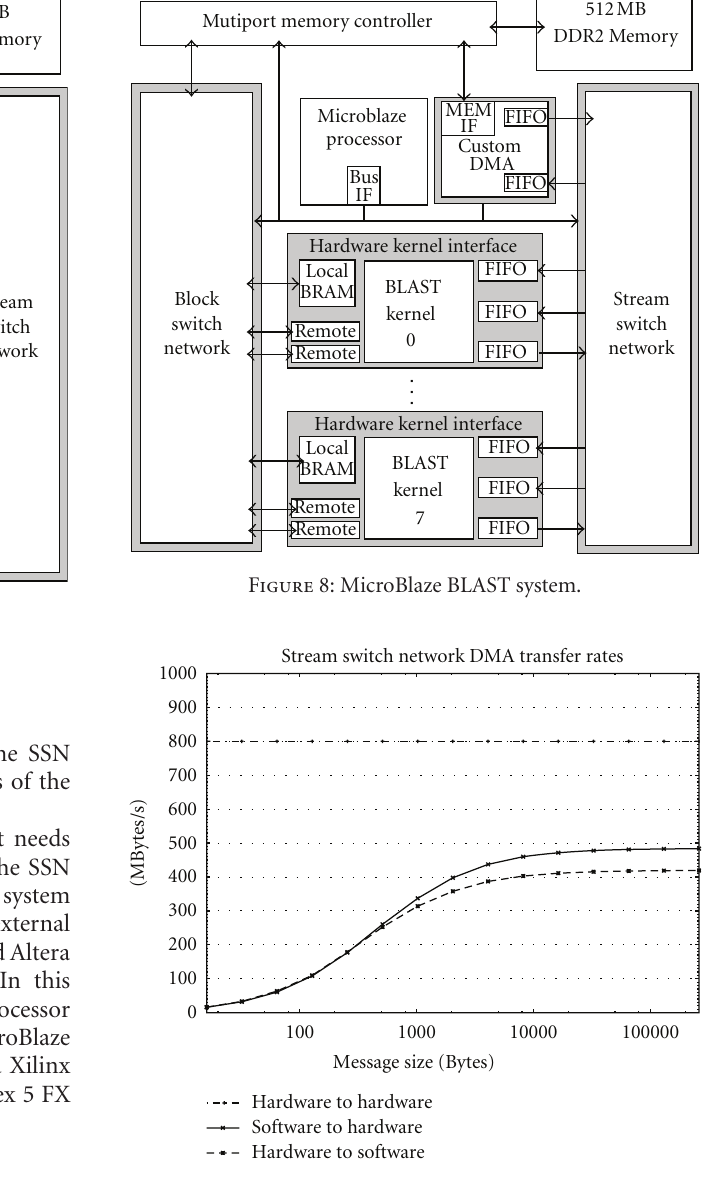
Figure 9: Stream bandwidth across hardware and software with 200 MHz SSN